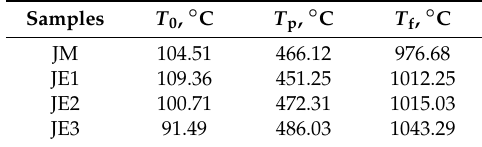
Table 4. The characteristic temperatures of different briquettes.